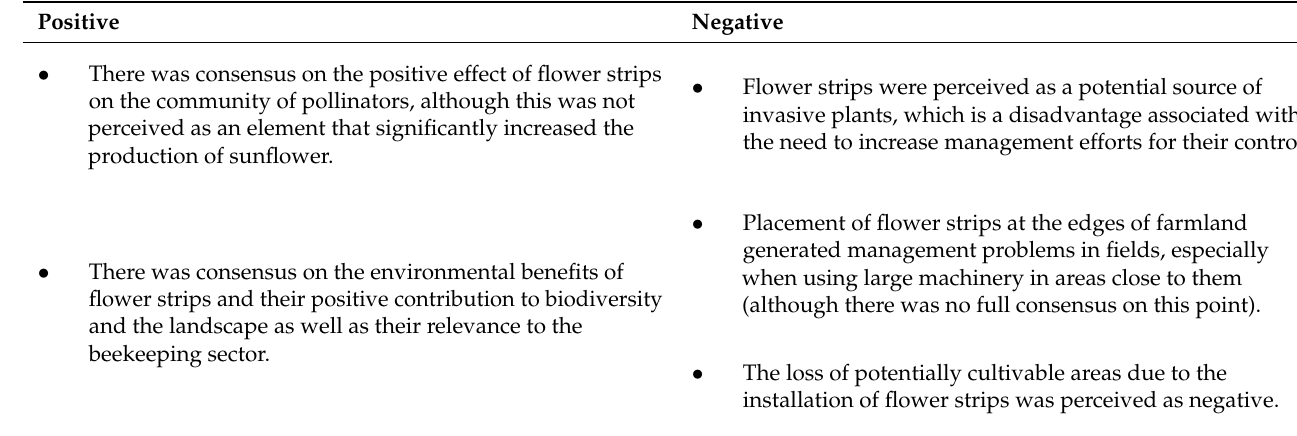
Table 2. The major positive and negative effects of flower strips as perceived by